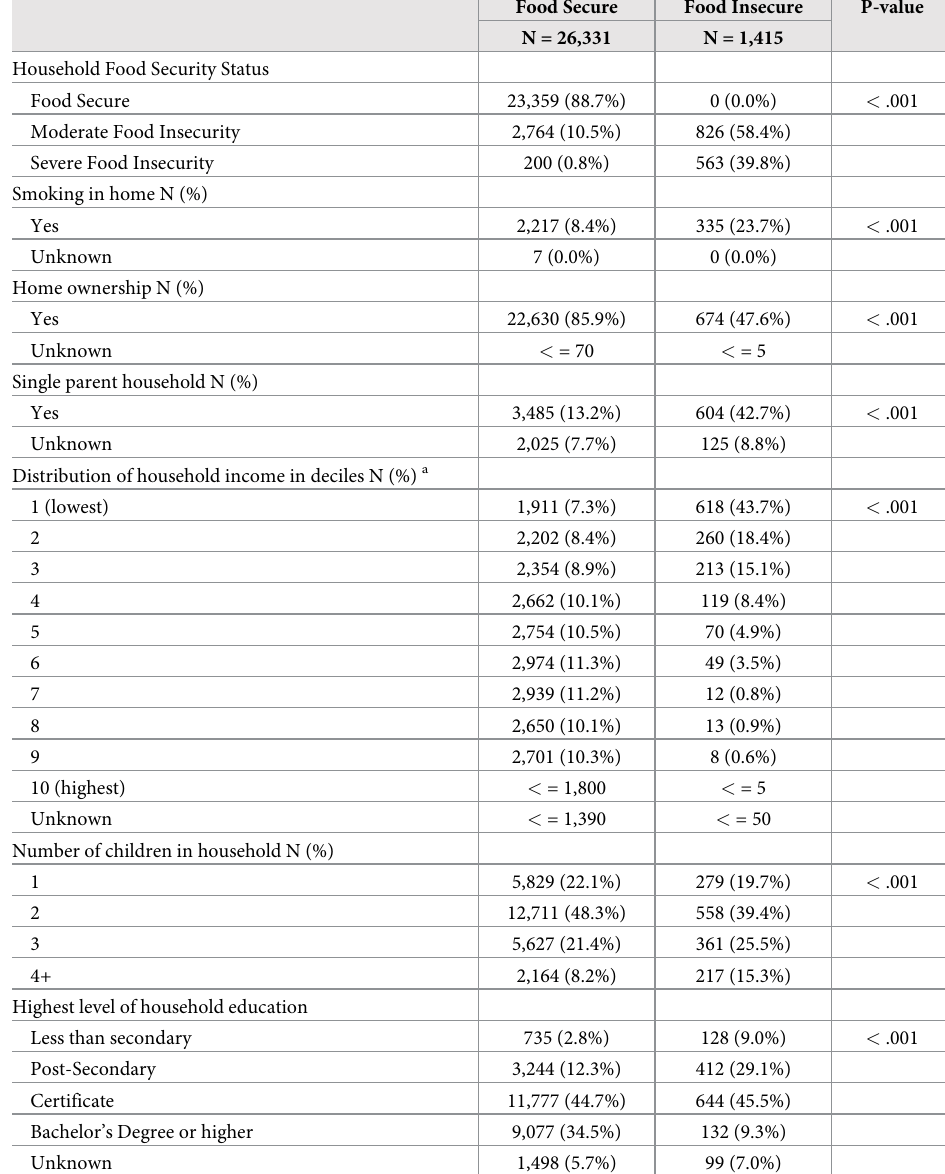
Table 2. Household characteristics of food insecure and secure children in Ontario,